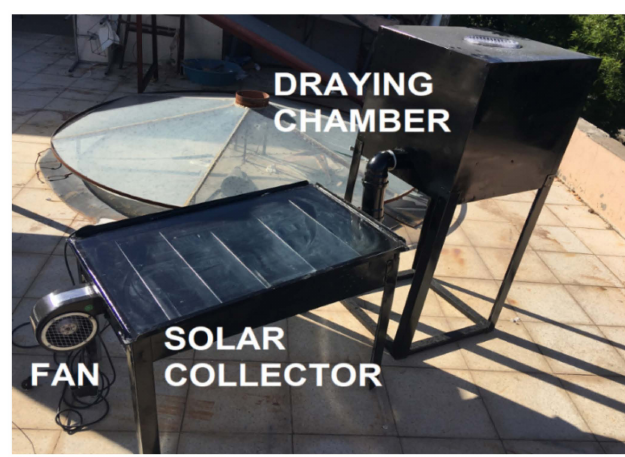
Figure 2. Experimental